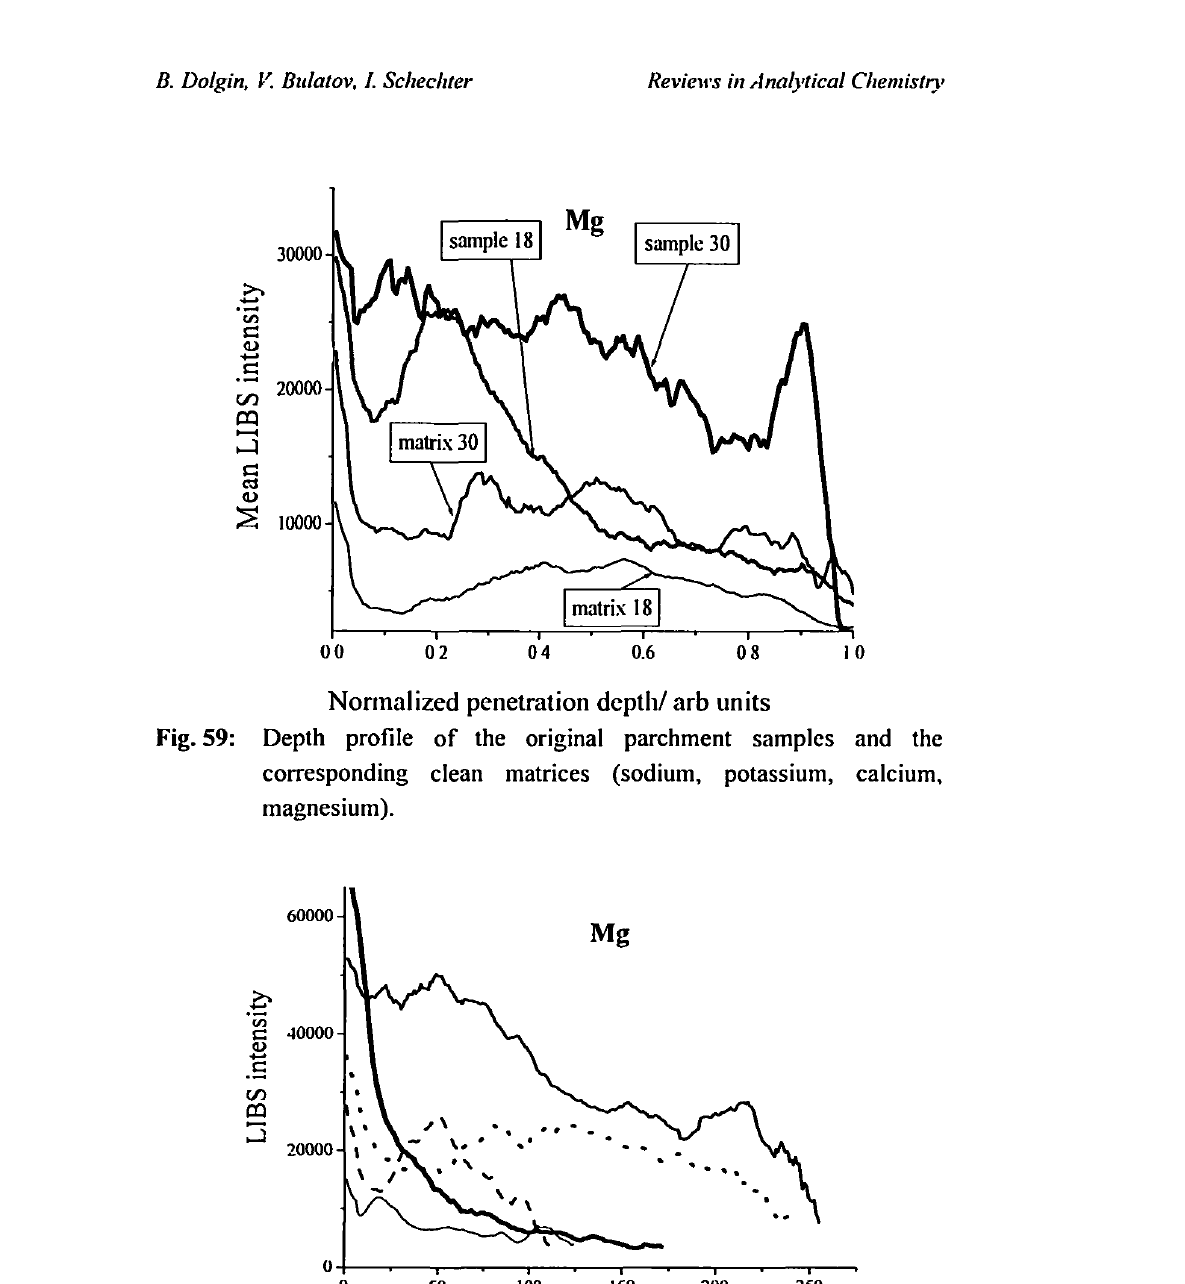
Fig. 60: Magnesium depth profiles of modem and historical parchment